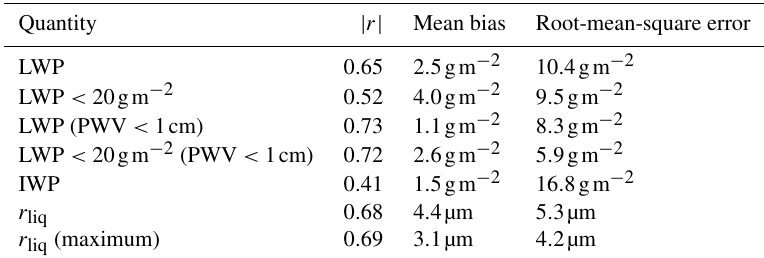
Table 6. Results of the comparison between TCWret and Cloudnet. Mean bias and root-mean-square error refer to the difference in both datasets.